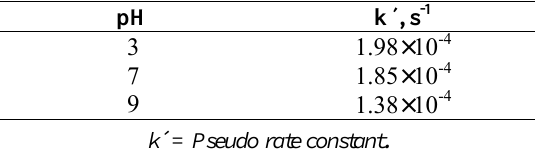
/ZnO at various pHs. [ZnO] = 3